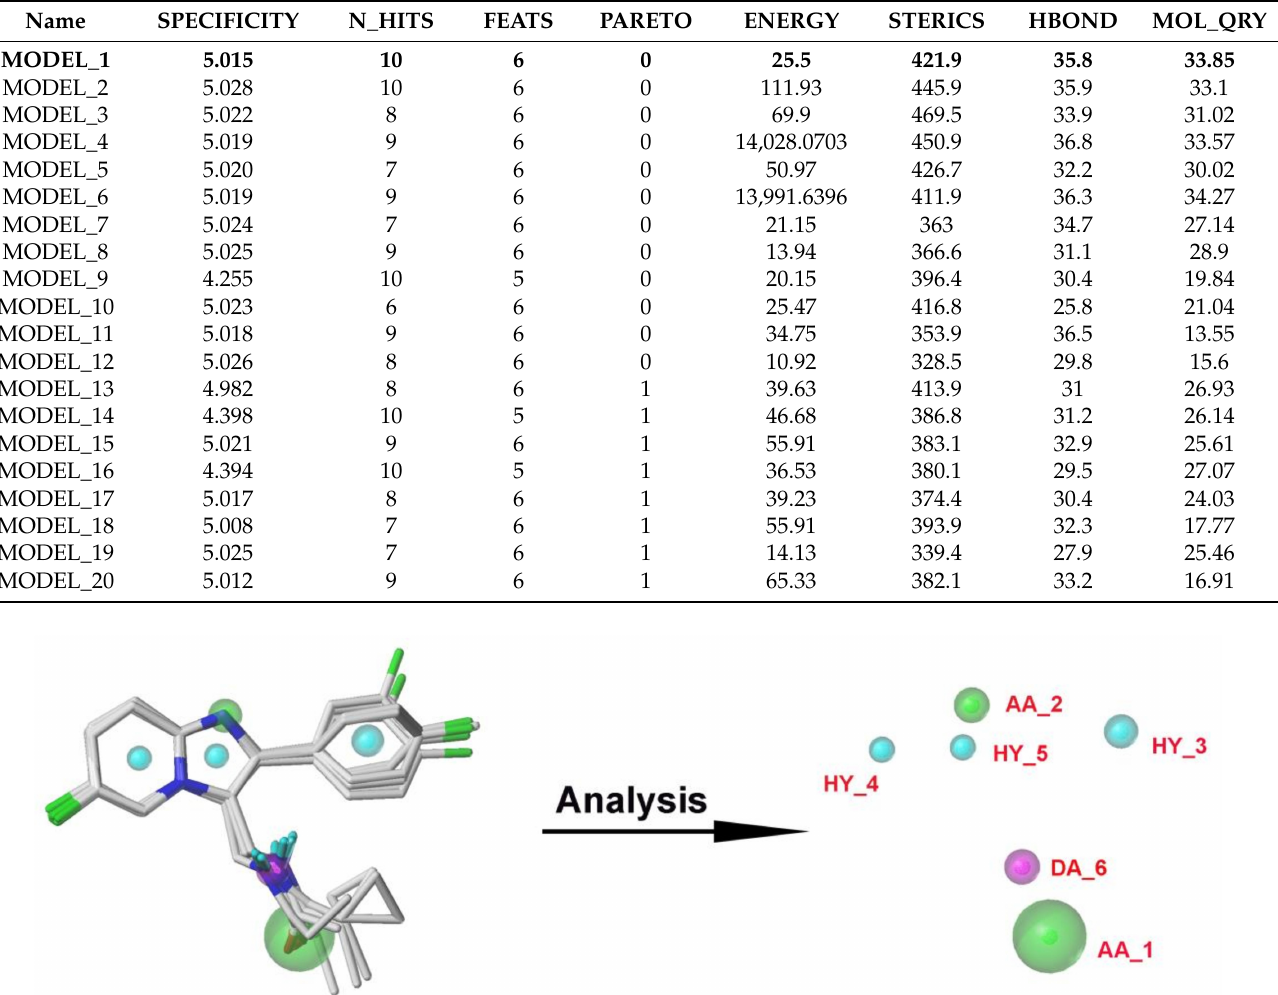
Table 4. Statistical results of the pharmacophore models.